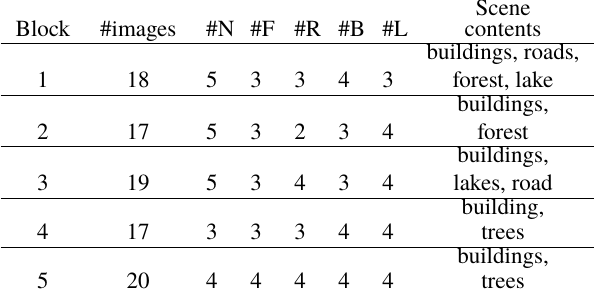
Table 2. Details of the image blocks used for determining image orientation. #N #F #R #B #L: the number of images from nadir, front, right, back and left camera,